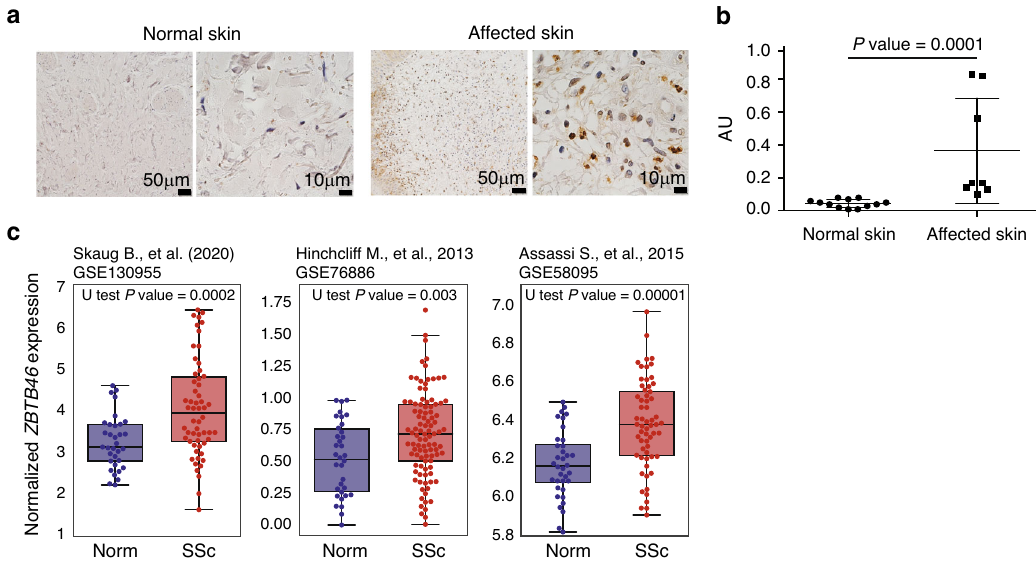
Fig. 5 Conventional dendritic cells were more in fi ltrated in affected compare with normal skin. ( a ) Immunohistochemistry analysis of ZBTB46 expression in normal and affected skin from SSc patient. 12 normal skin samples and 8 affected skin samples were included in our experiments. ( b ) Average expression of ZBTB46 protein in normal ( n = 12) and affected ( n = 8) skin from SSc patient. P value was estimated by one-sided Mann – Whitney U test. The upper, centre, and lower line indicates 75% quantile + 1.5 * interquartile range (IQR), 50% quantile and 25% quantile − 1.5 * IQR respectively. Source data are provided as a Source Data fi le. ( c ) The expression of cDC (conventional dendritic cells) marker gene ZBTB46 in normal ( n = 33, 34, 36) and SSc ( n = 58, 99, 61) skin in three published datasets. P value was estimated by one-sided Mann – Whitney U test. The upper, centre, and lower line of the box indicates 75%, 50%, and 25% quantile, respectively. The upper and lower whisker of the boxplot indicates 75% quantile + 1.5 * interquartile range (IQR) and 25% quantile − 1.5 * IQR. Source data are provided as a Source Data fi